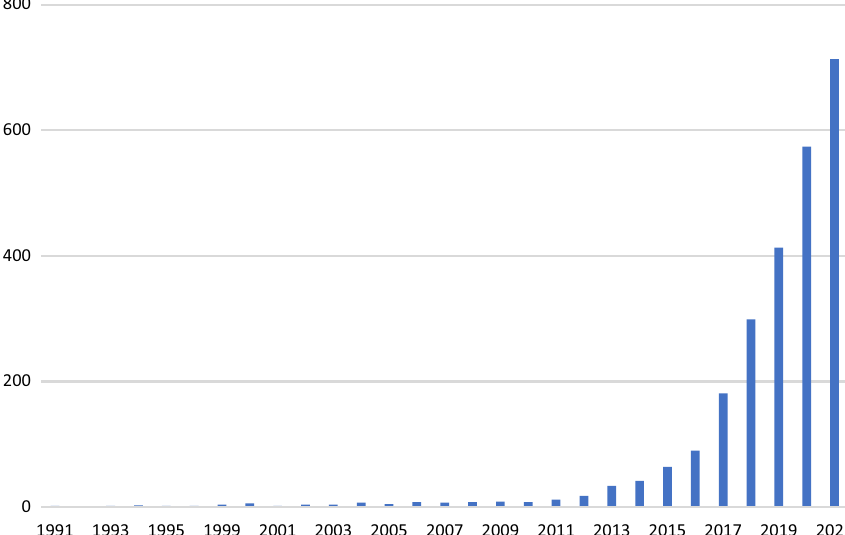
Fig. 2 Number of publications on environmentally sustainable smart cities between 1991 and